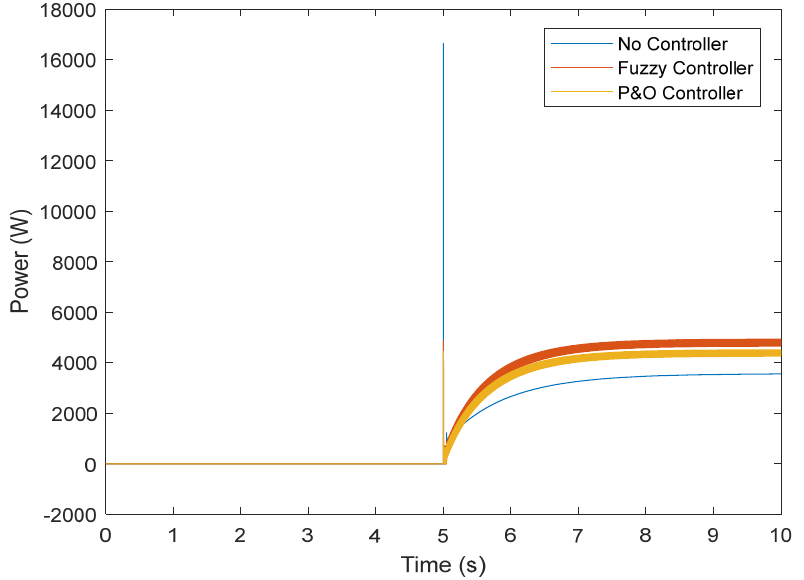
Figure 17. Output power of the fuel cell in the transient state.